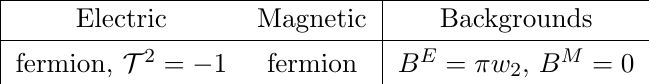
Table 1 . Six non-anomalous couplings of U(1) gauge theory at (cid:18) = 0 mod 2 (cid:25) to the backgrounds of time-reversing Lorentz symmetry. The electric particle has electric and magnetic charges (1 ; 0), while the magnetic particle has charges (0 ; 1). The statistics and Kramer degeneracy of the particles are according to [4]. In this note we show the di(cid:11)erent couplings, or symmetry-enriched phases, correspond to di(cid:11)erent backgrounds for the electric and magnetic one-form symmetry as explained in section 5.2.